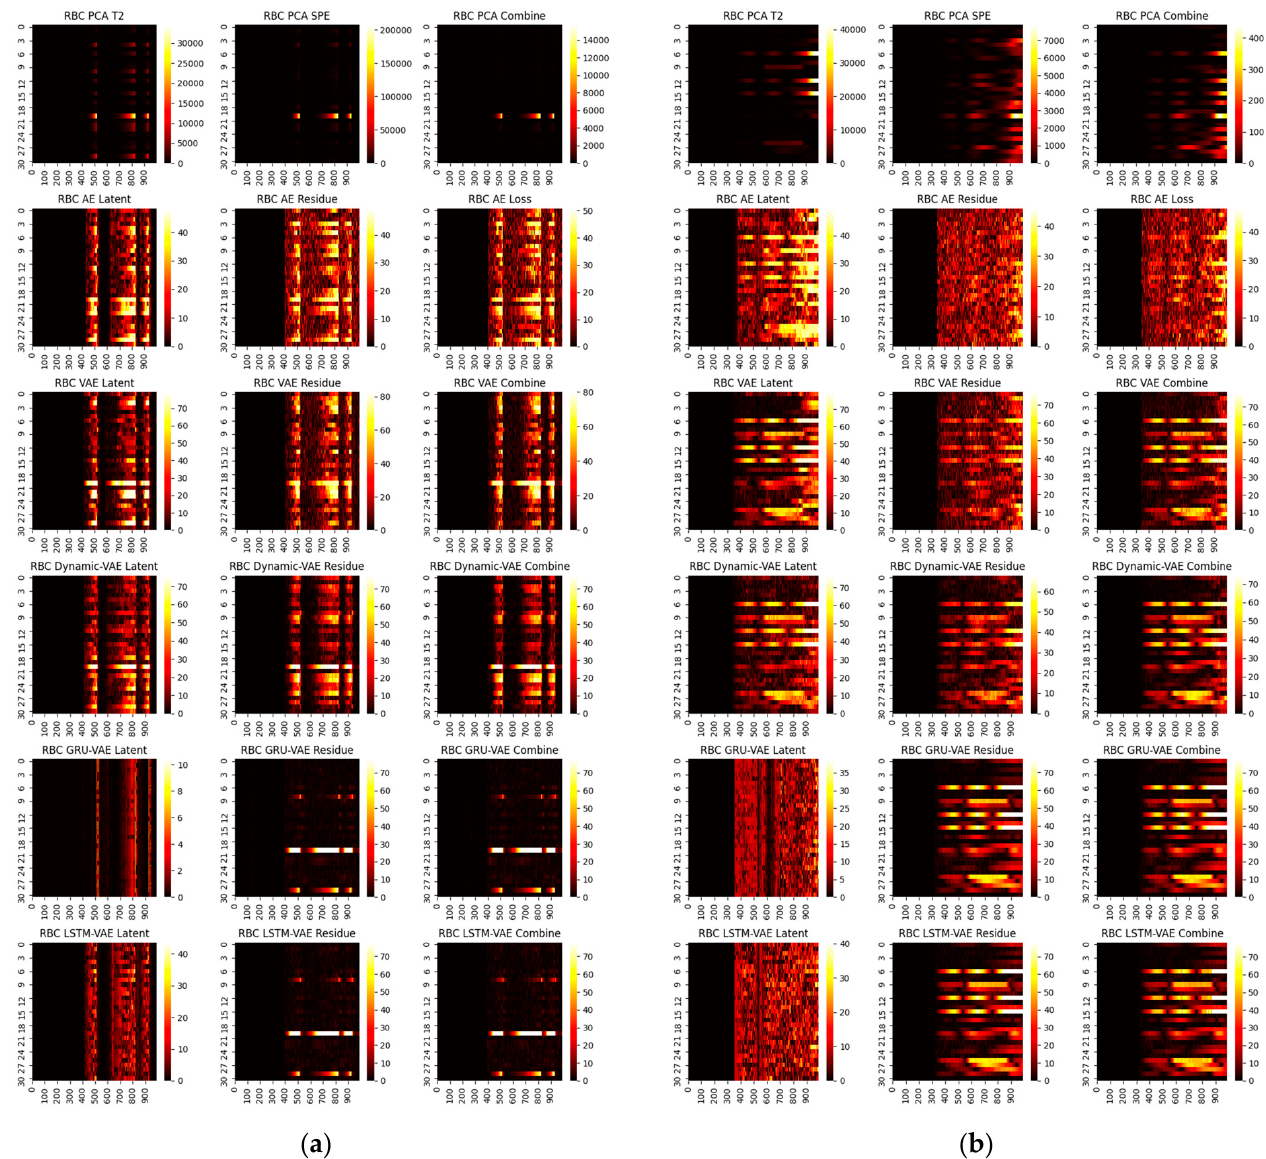
Figure 9. RBC contribution plots for large faults: ( a ) fault 17, ( b ) fault 13.